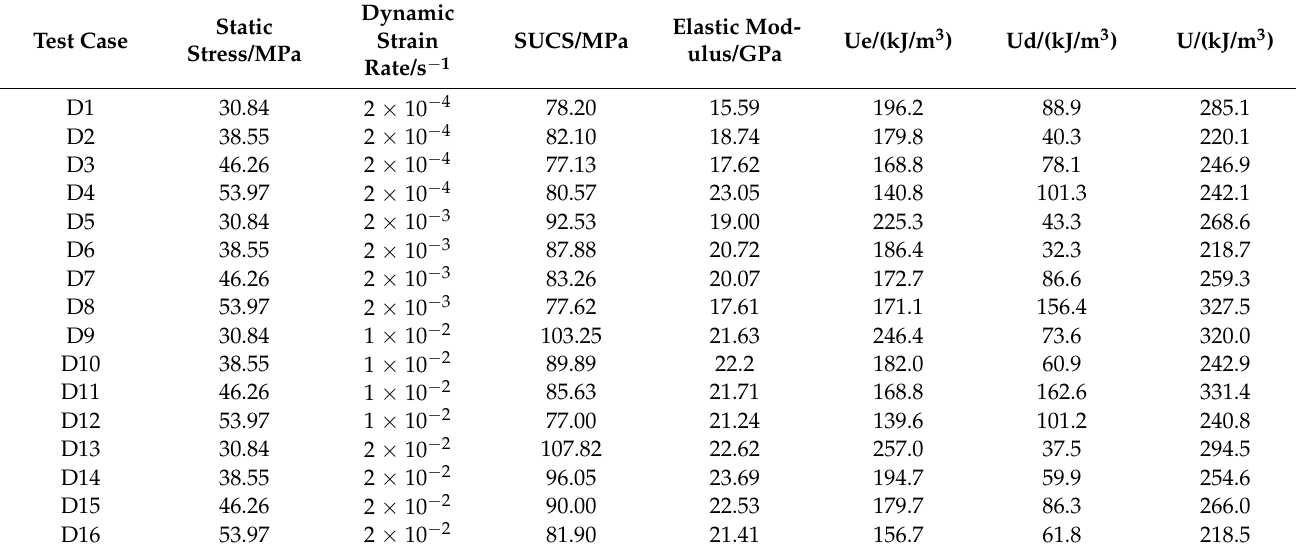
Table 3. The experimental results of superimposed static and dynamic loading